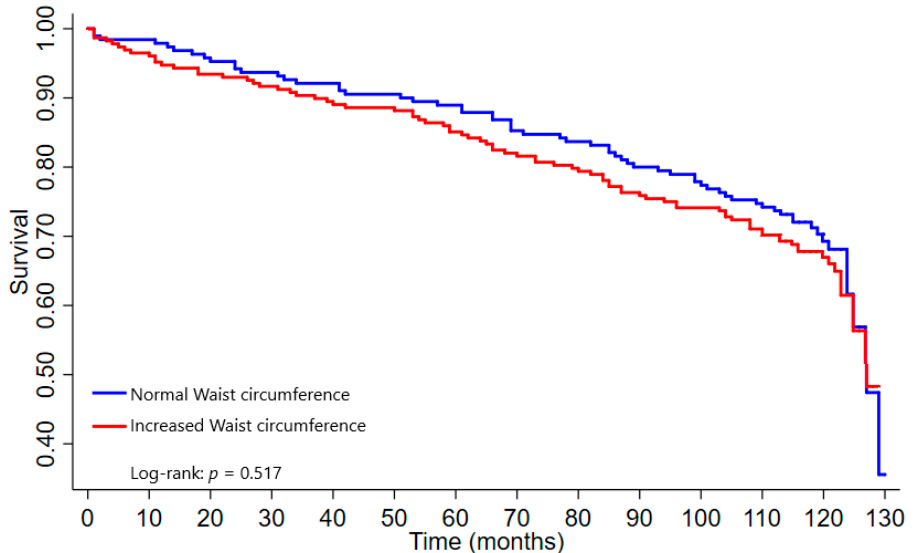
Figure 3. Survival curve according to waist circumference (Silveira et al., 2020) [28]. Note: Increased waist circumference ≥ 77.8 cm for women and WC ≥ 98.8 cm for men.